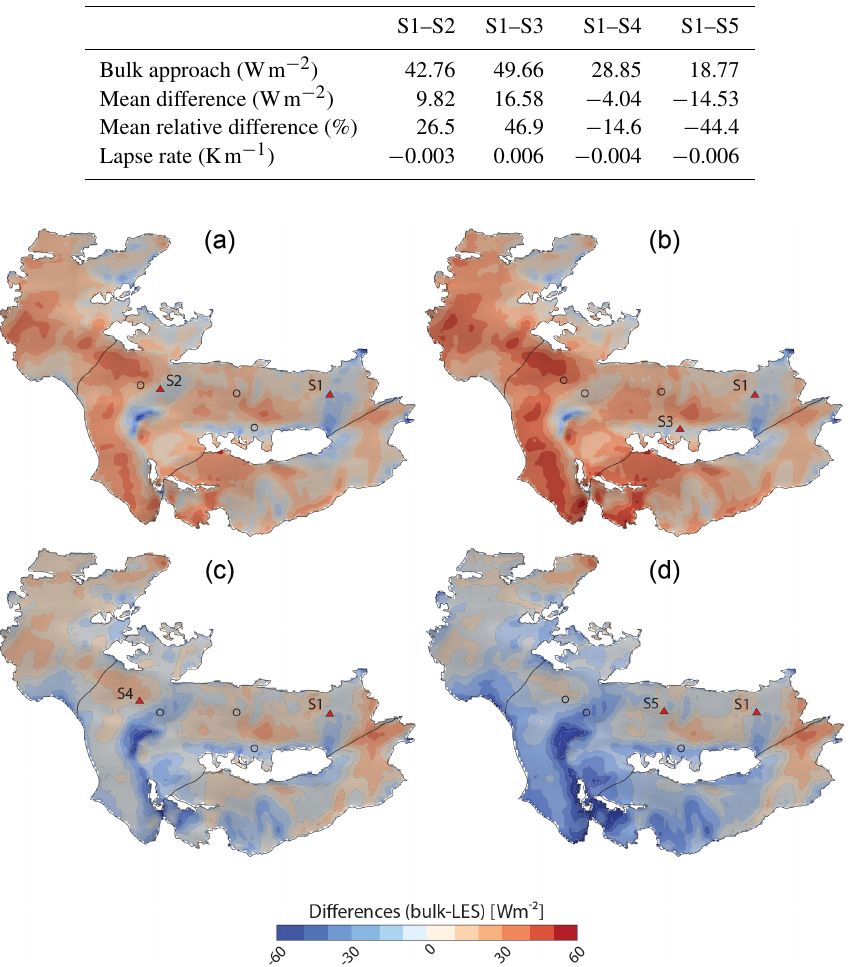
Figure 11. Differences in the surface sensible heat fluxes between the LES and the bulk method. The cases (a) – (d) indicate different extrapolation scenarios based on the pseudo-observations (S1, S2–S5). Positive differences correspond to regions where the fluxes have been overestimated by the bulk